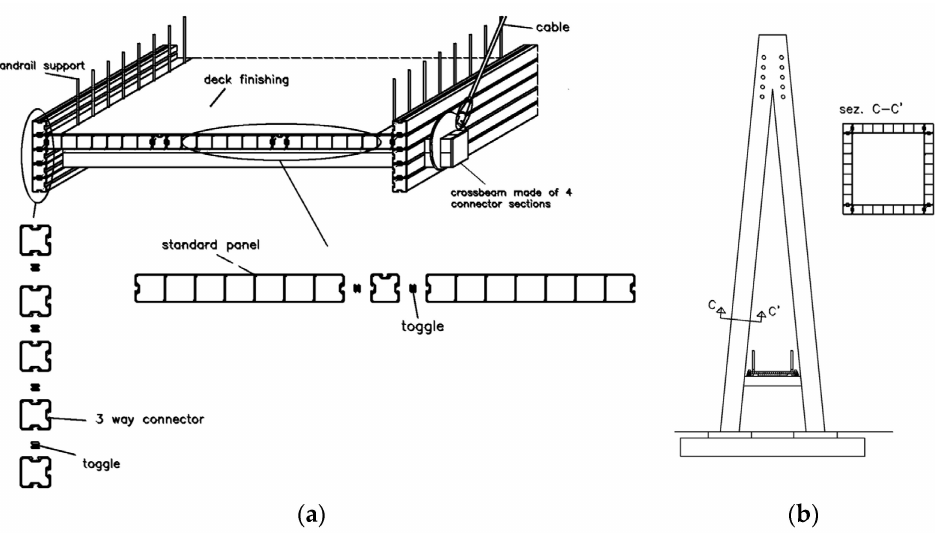
Figure 2. Details of the footbridge: ( a ) the cross-section and ( b ) the